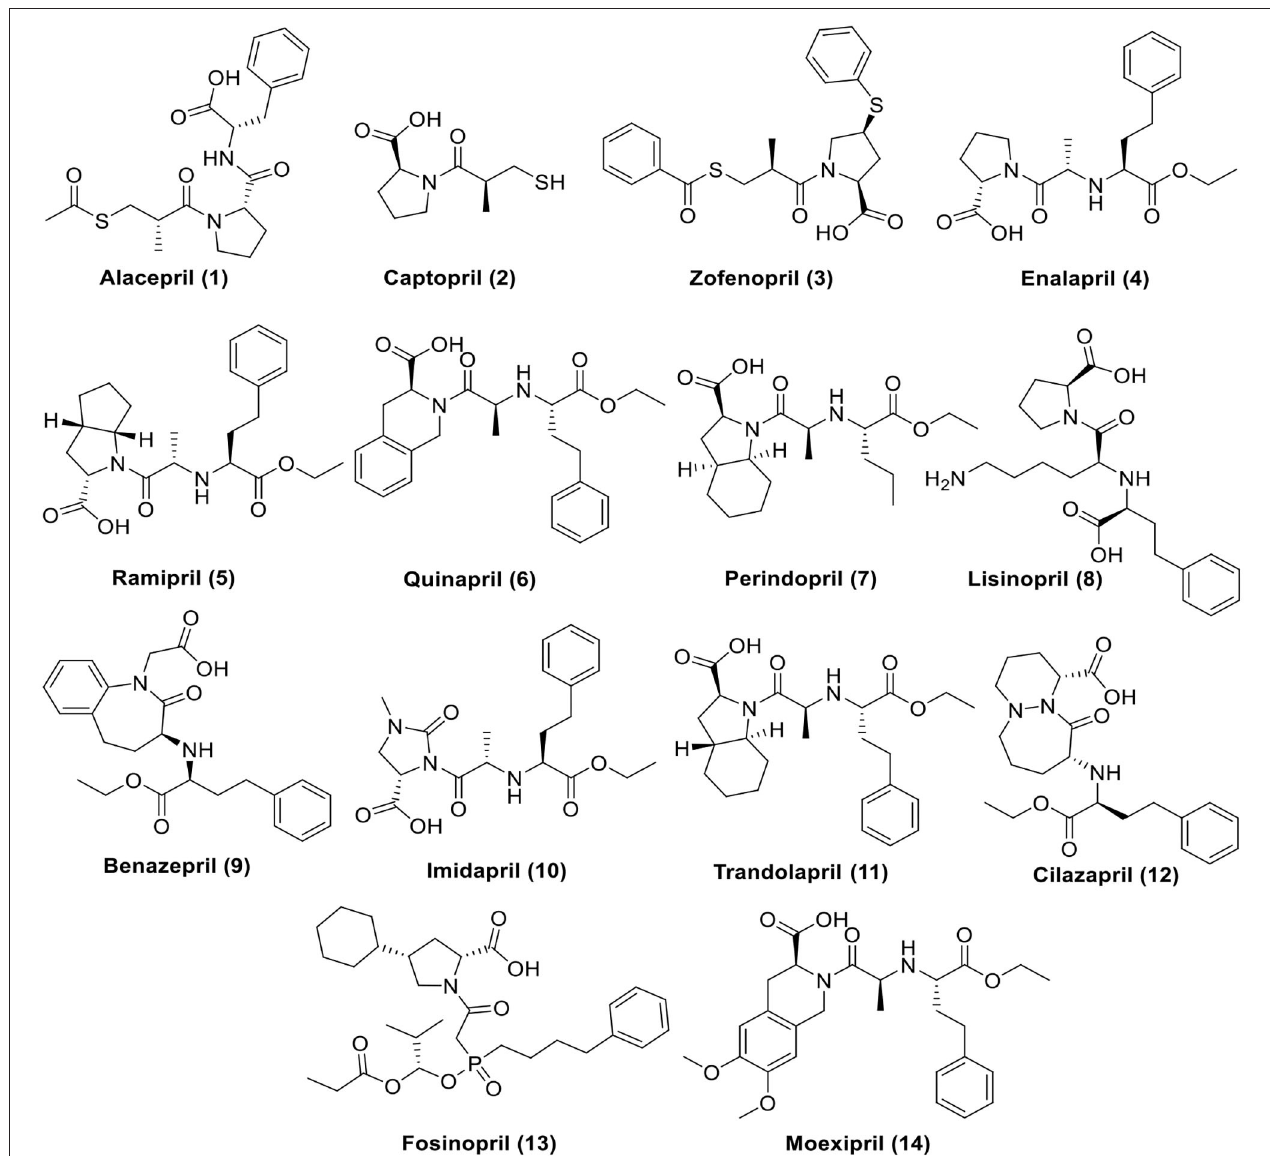
FIGURE 1 | Chemical structures of the tested